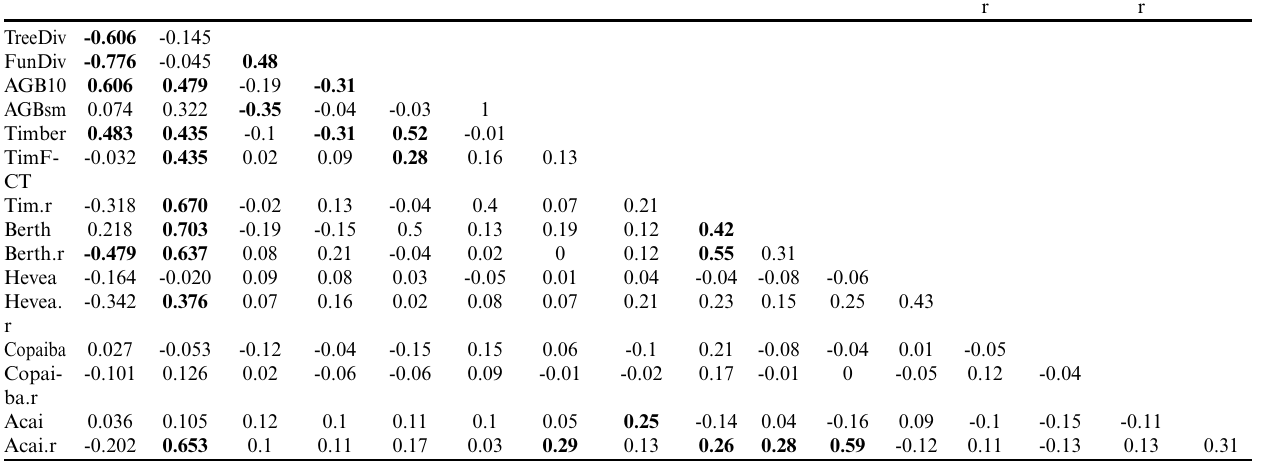
Table 4 . Correlations among forest value components (see Table 1 for details) across the 69 plots, and loadings on the first two axes of a principal components analysis (PCA). Significant correlations and loadings are indicated in